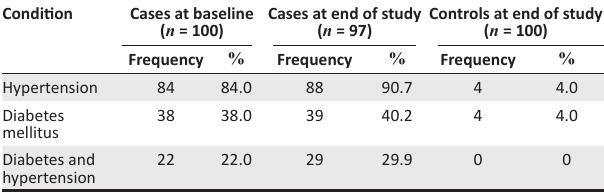
TABLE 2: Disease-related information among cases and controls. Condition